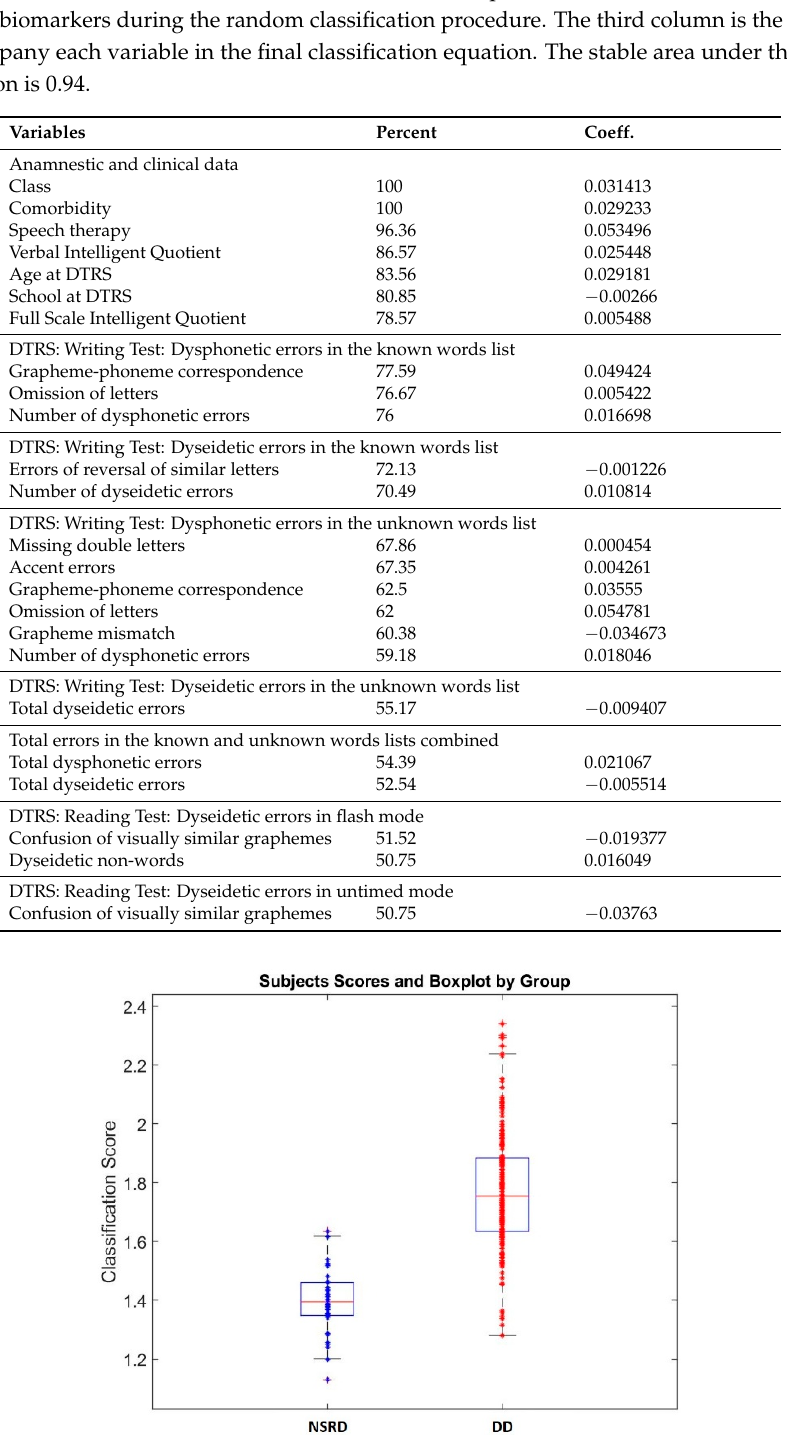
Figure 3. Scatterplot showing the individual scores obtained by the classification equation of the DTRS variables, for the subjects of the two groups NSRD (unspecific reading delay) and DD (dysphonetic dyslexics). For each group a boxplot with the mean and standard deviation of the individual values is shown.